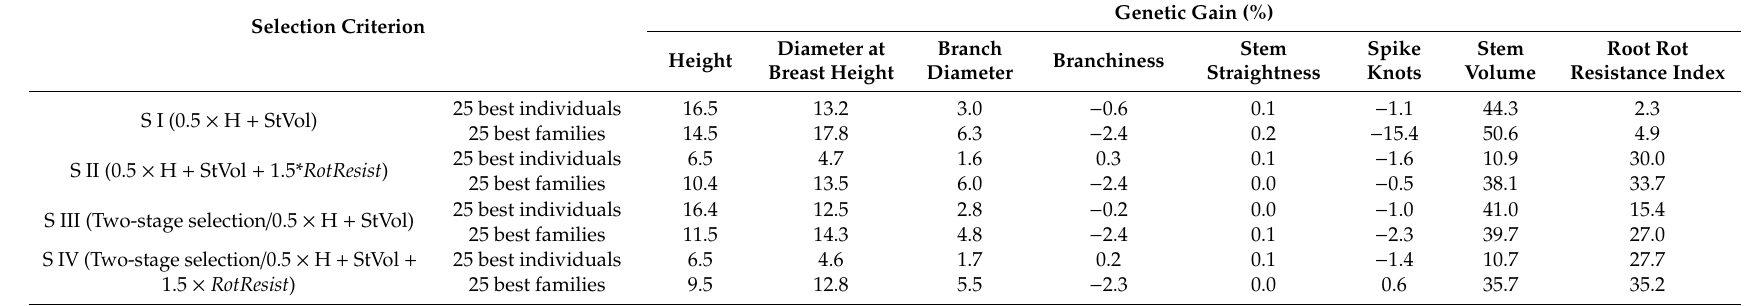
Table 3. Estimated genetic gain for the studied variables using di ff erent selection criteria: S I—selection index with only height (H) and stem volume (StVol) included; S II—selection index with root rot resistance index ( RotResist ) included; S III—two-stage selection with the selection of 30% of individuals from families with the greatest resistance prior to the application of conventional selection index; S IV—two-stage selection with the selection of 30% of families with the greatest resistance prior to the application of selection index with RotResist included. For all criteria, the selection of the 25 best individuals within the best families or selection of the 25 best families regarding the selection index are